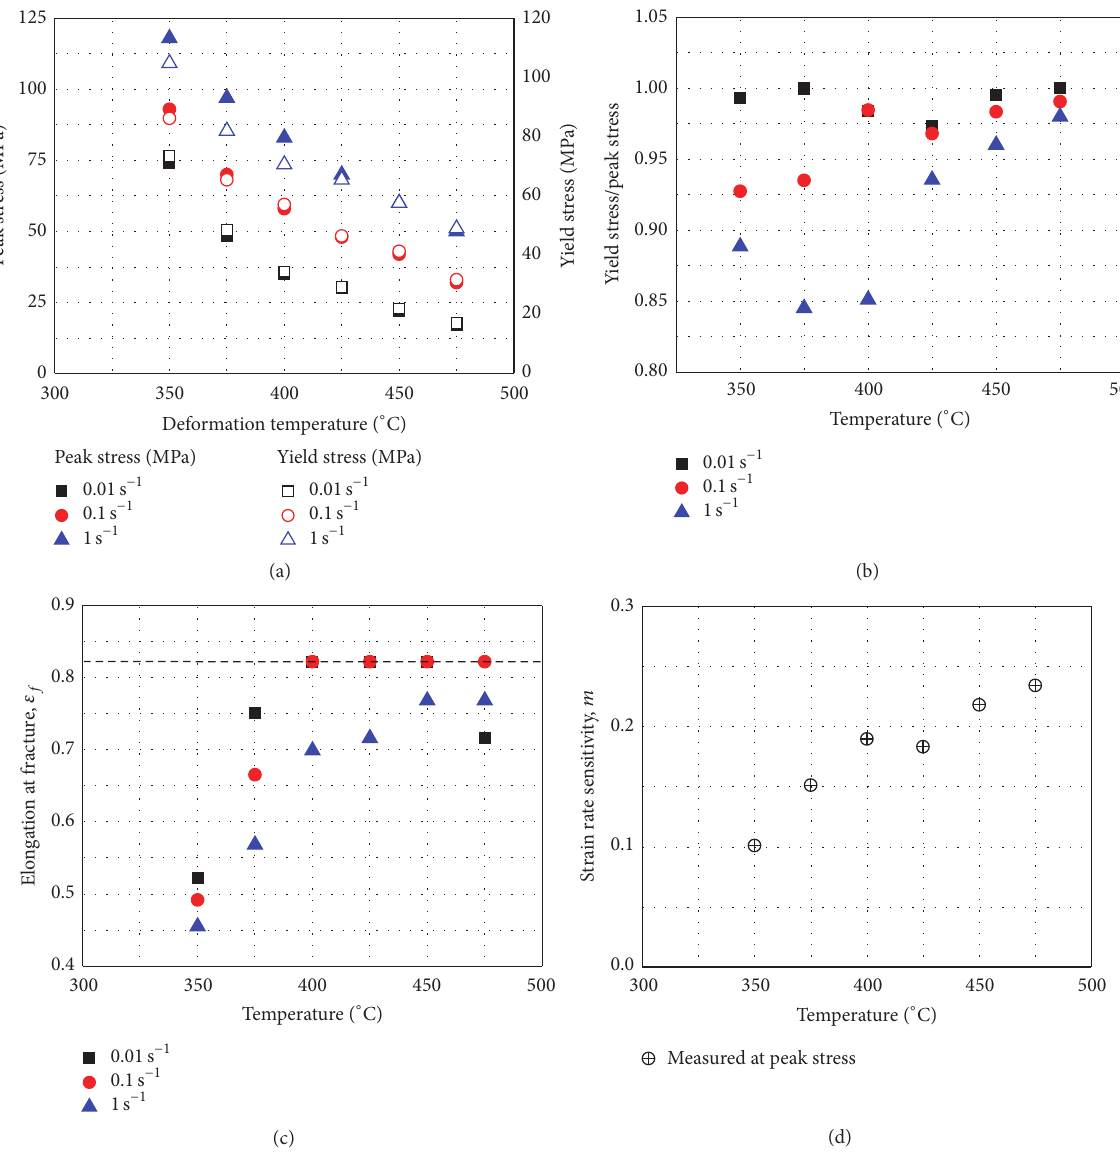
Figure 4: (a) Peak and yield stress, (b) yield stress/peak stress ratio, (c) elongation at fracture, and (d) strain rate sensitivity of AW-7921-T4 at temperatures between 350 and 475 ∘ C and at strain rates between 0.01 and 1s −1 . The dashed line in (c) indicates the measurement limit for the deformation